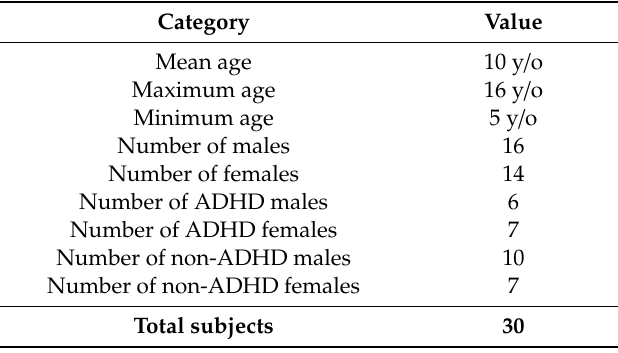
Table 1. Subject Distribution; ADHD: Attention-deficit / hyperactivity disorder.